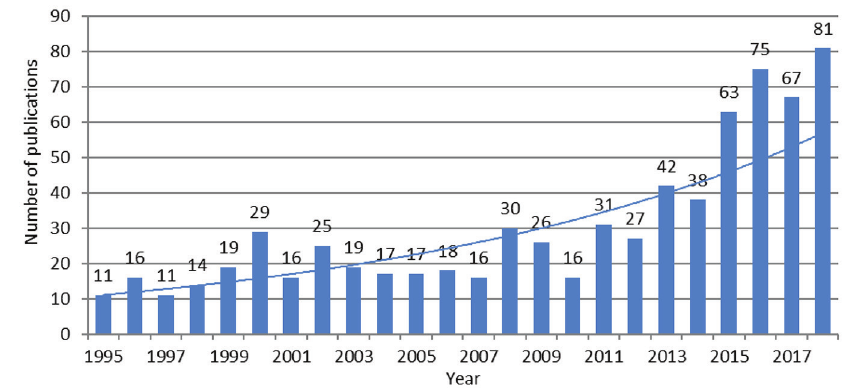
Figure 1. Number of FM publications per year from 1995 to